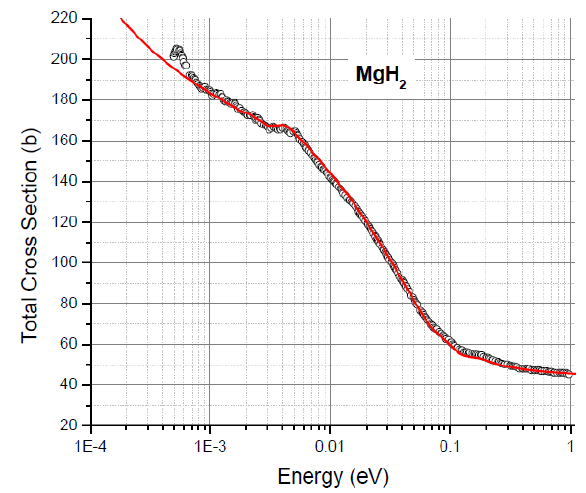
Fig. 8 : Calculated total cross section of room temperature MgH 2 (solid line) and the experimental points of Ref.[26].